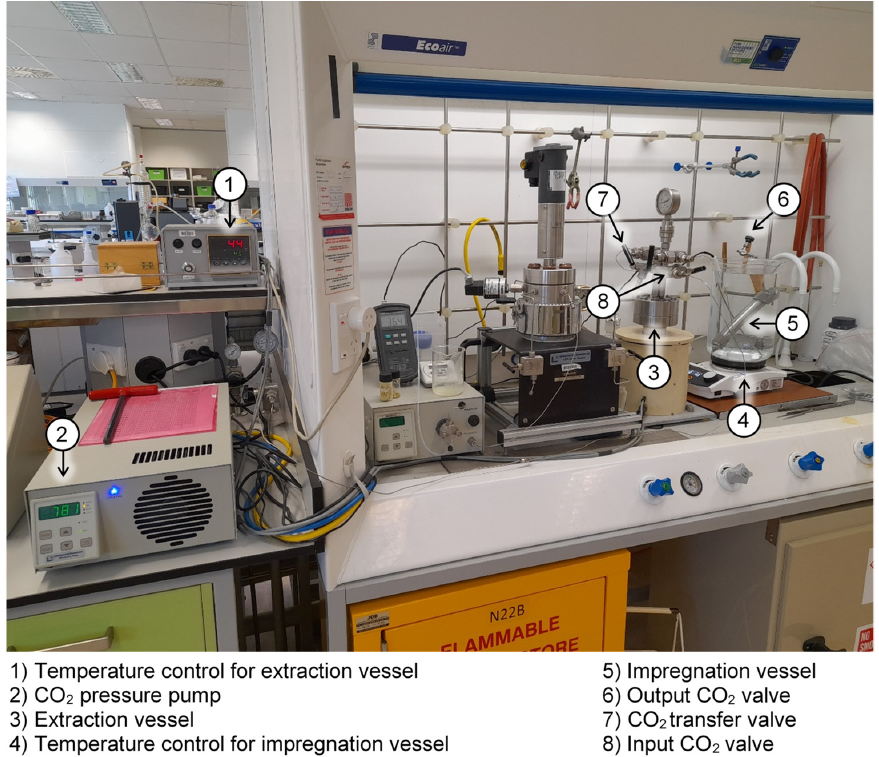
Figure 5. Picture of the actual experimental set set-up used in this study.